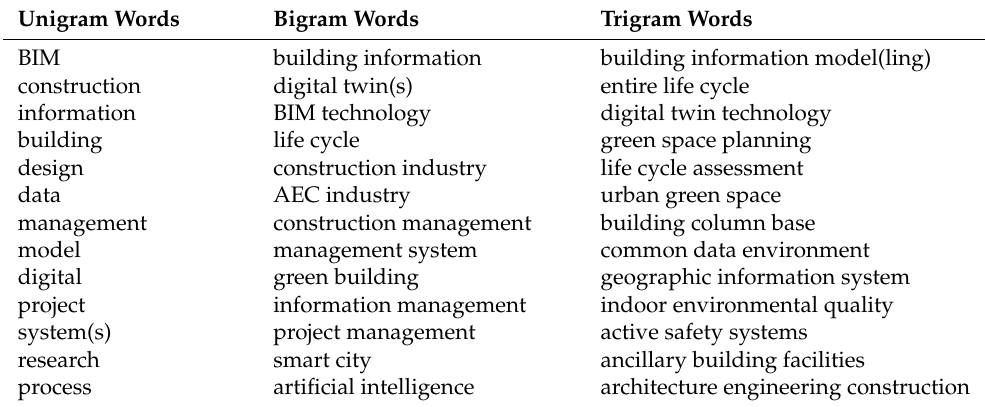
Table 8. Content Analysis in Unigram, Bigram, and Trigram